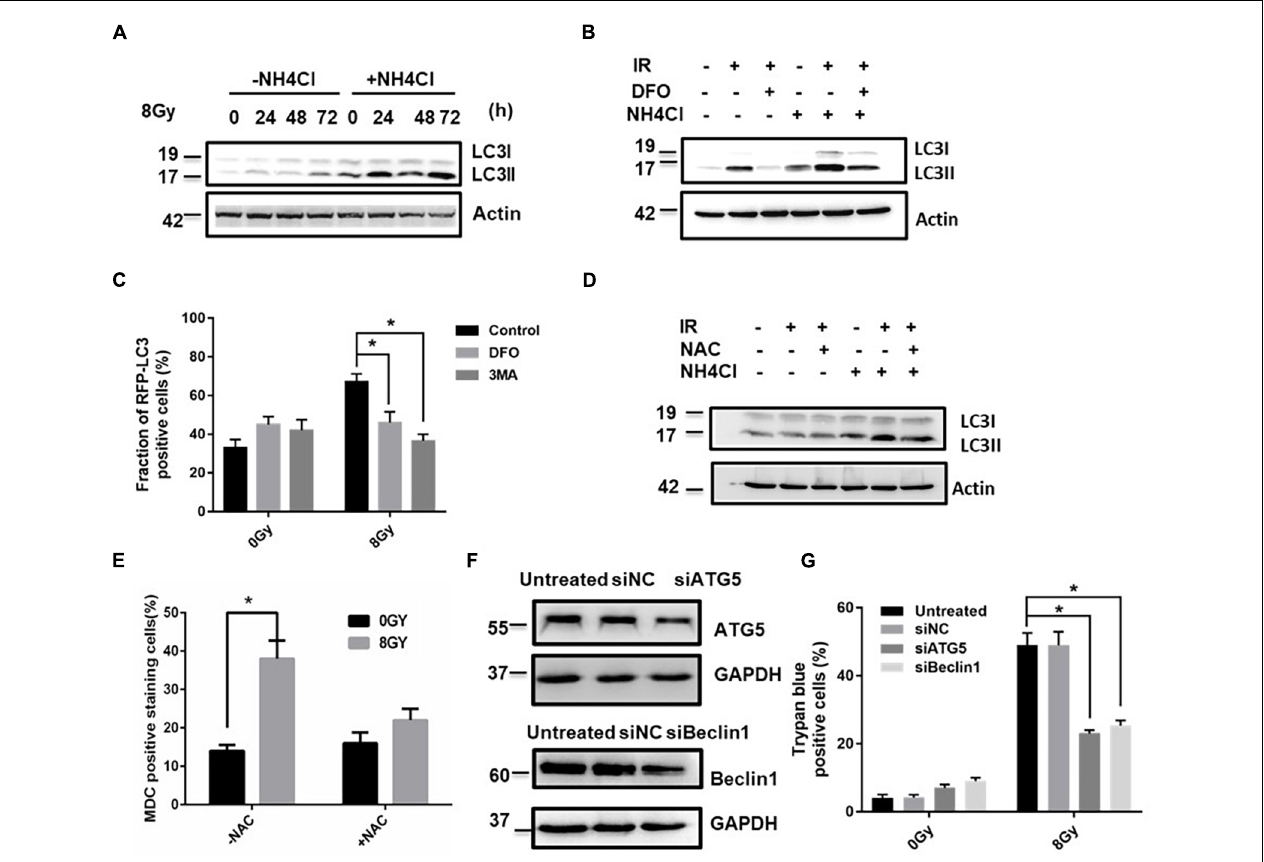
FIGURE 6 | ROS regulated radiation-induced autophagic cell death in MDA-MB-231 breast cancer cells. The time-course analysis of autophagy marker MAPLC3-II by western blot in the absence and presence of NH4Cl after 8 Gy radiation (A) . The effects of DFO on the autophagy flux by western blot after 8 Gy radiation (B) . mRFP-LC3B puncta per cell were calculated after 8 Gy treatment (C) . The effects of NAC (10 mM) on the autophagy flux by western blot after 8 Gy radiation (D) . MDC staining was used to detect autophagy occurrence with flow cytometry analysis (E) . The autophagy genes Atg5 and Beclin-1 was knocked down by siRNAs for 48 h in MDA-MB-231 cells and the transfection efficiency was demonstrated by western blot (F) . The trypan blue assay shows the effects of silencing of Atg5 or Beclin-1 on radiation-induced cell death (G) . These results were representative of three independent experiments and expressed as means ± SD. P -values were calculated using repeated measure ANOVA with P < 0.05 being considered as statistical significance, * P <